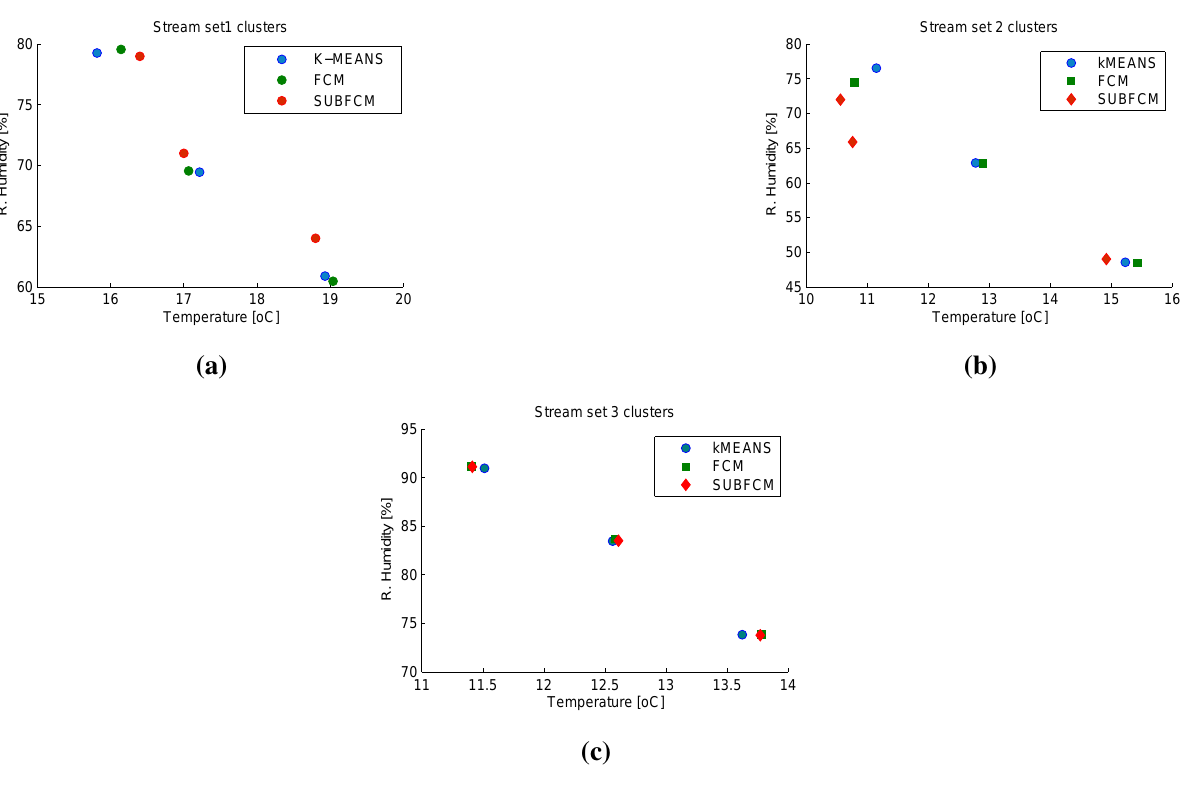
Figure 5. A snapshot of the first sliding windows of cluster heads, one to three. ( a ) snapshot of the first sliding windows of cluster head one; ( b ) snapshot of the first sliding windows of cluster head two; ( c ) snapshot of the first sliding windows of cluster head three.